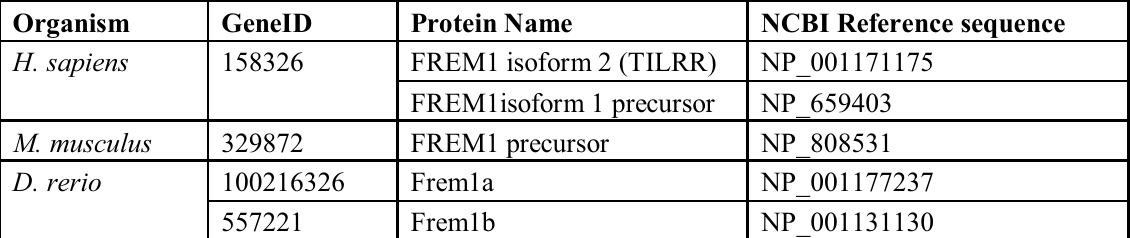
Table 1. Accession numbers of FREM1